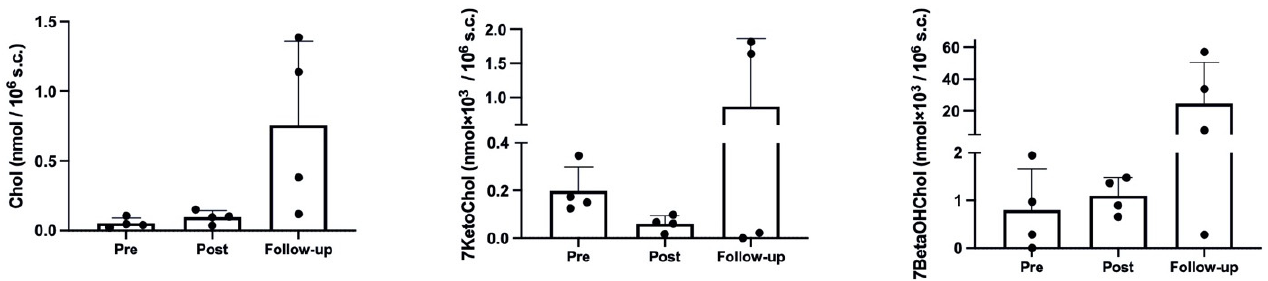
Figure 2. Cholesterol and oxysterol